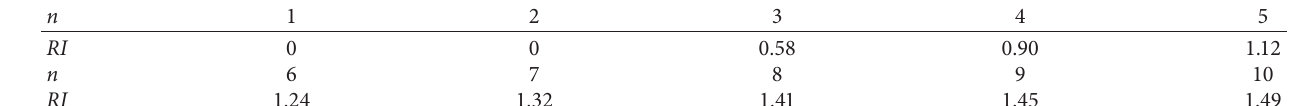
Table 2: Correspondence between RI and n .